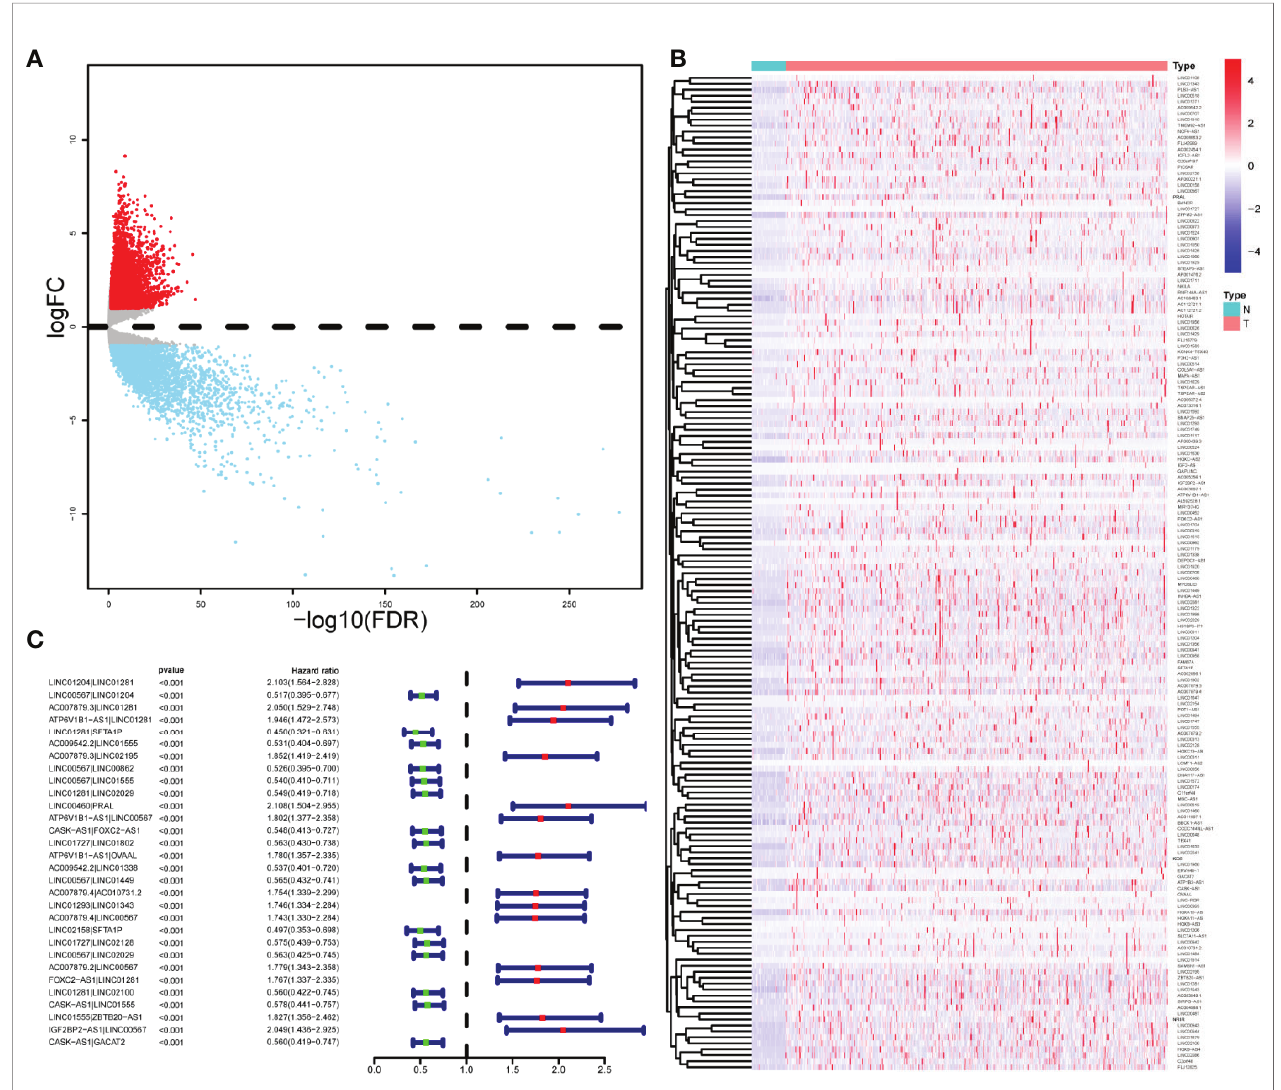
FIGURE 1 | Identi fi cation of DEirlncRNAs and IRLPs using TCGA datasets. (A) For the volcanic map of 6720 differentially expressed genes, red points represent log2FC >1.5; blue points represent log2FC<-1.5, FDR < 0.05. (B) Heat maps of 167 immune related differential lncRNAs in normal and tumor samples. (C) Forest map showing 30 DEirlncRNA pairs related to prognosis identi fi ed by univariate COX